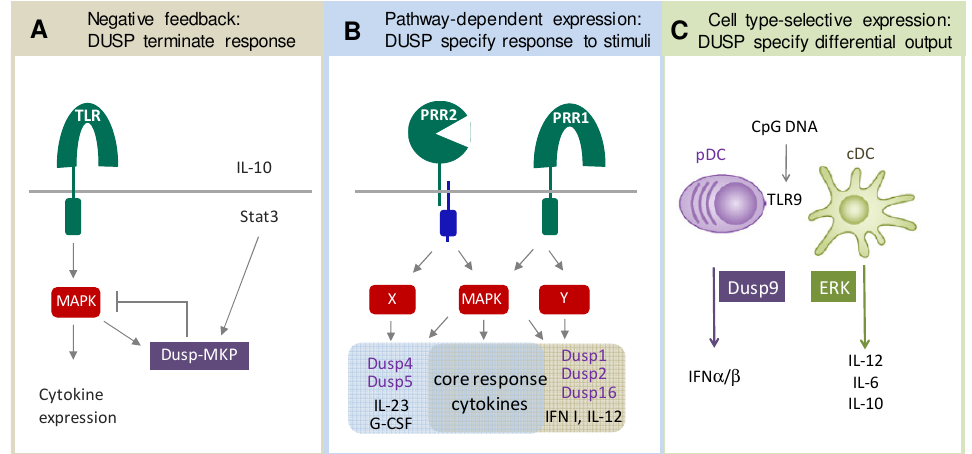
Figure 2. DUSP as regulators and specifiers of innate immune responses. ( A ) Negative feedback regulation of MAPK signaling by activation-induced DUSP upregulation, shown here as example TLR-induced DUSP1 that is enhanced by IL-10-STAT3 signaling. ( B ) Ligands for different pattern recognition receptors trigger overlapping yet distinct gene expression programs, including the differential expression of DUSP family members that then tune the amplitude and kinetics of MAPK activation. ( C ) Activation of the same pattern recognition receptor (here TLR9) in different cell types induces strikingly different cytokine outputs. Differential expression of DUSP genes (here DUSP9 in pDC, but not cDC) contributes to cell type-specificity of signaling and transcriptional responses.